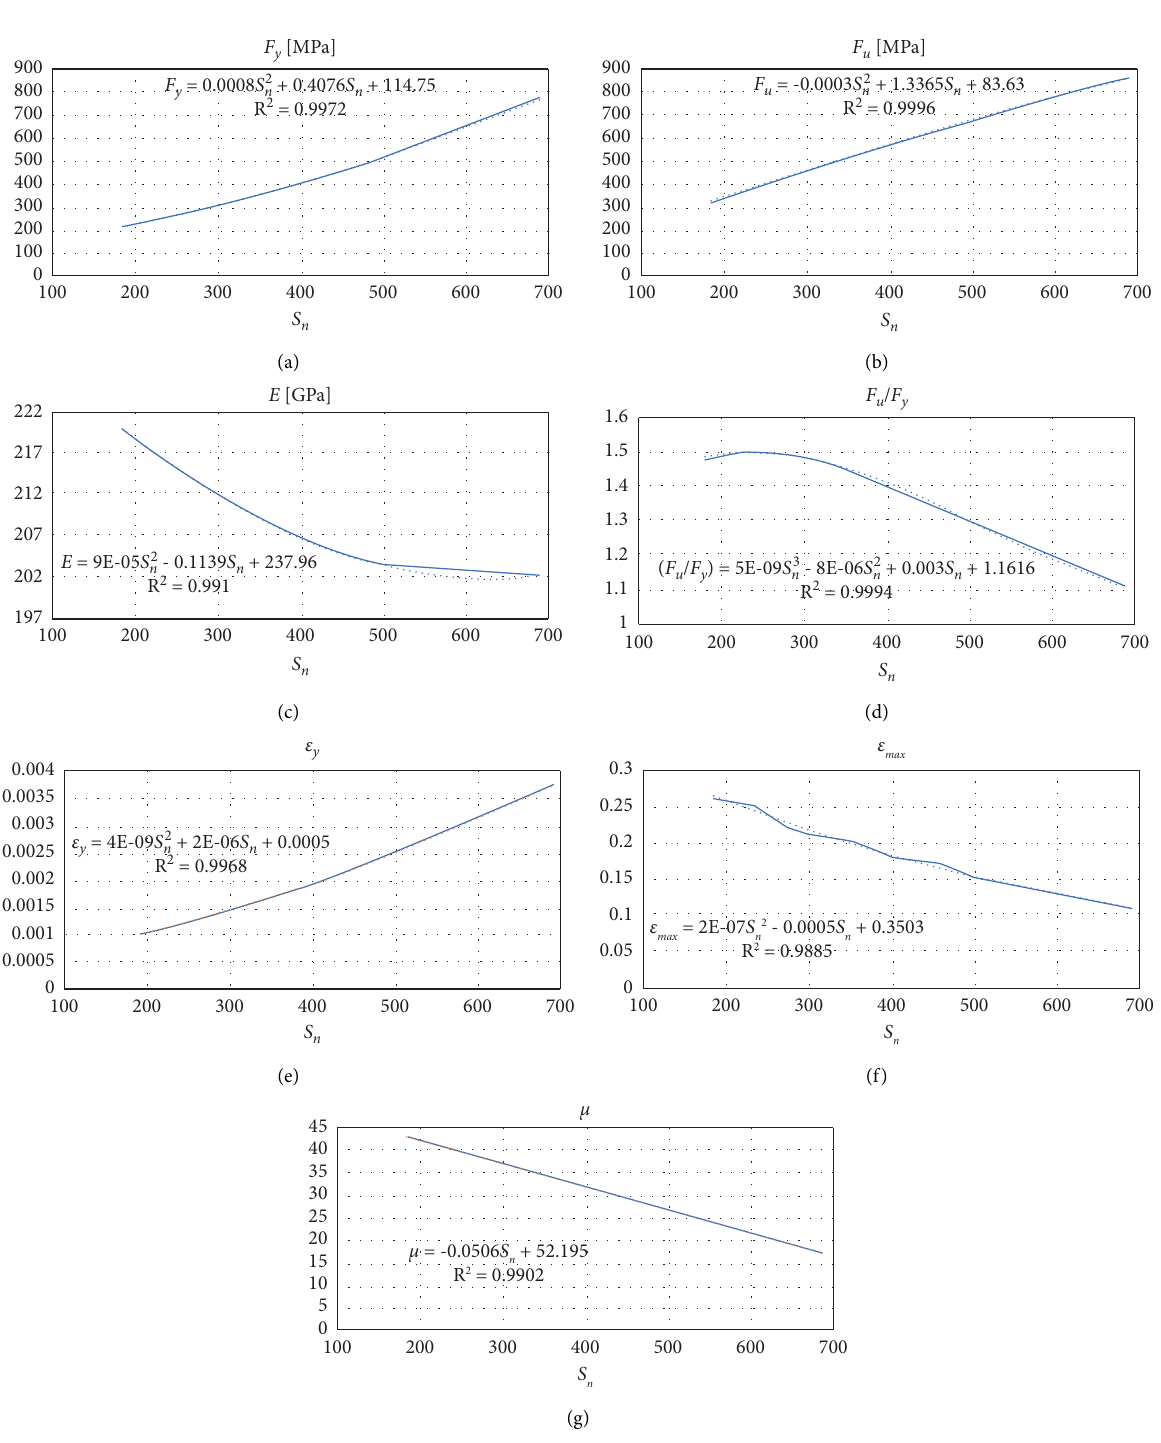
Figure 2: Regression curves based on equations